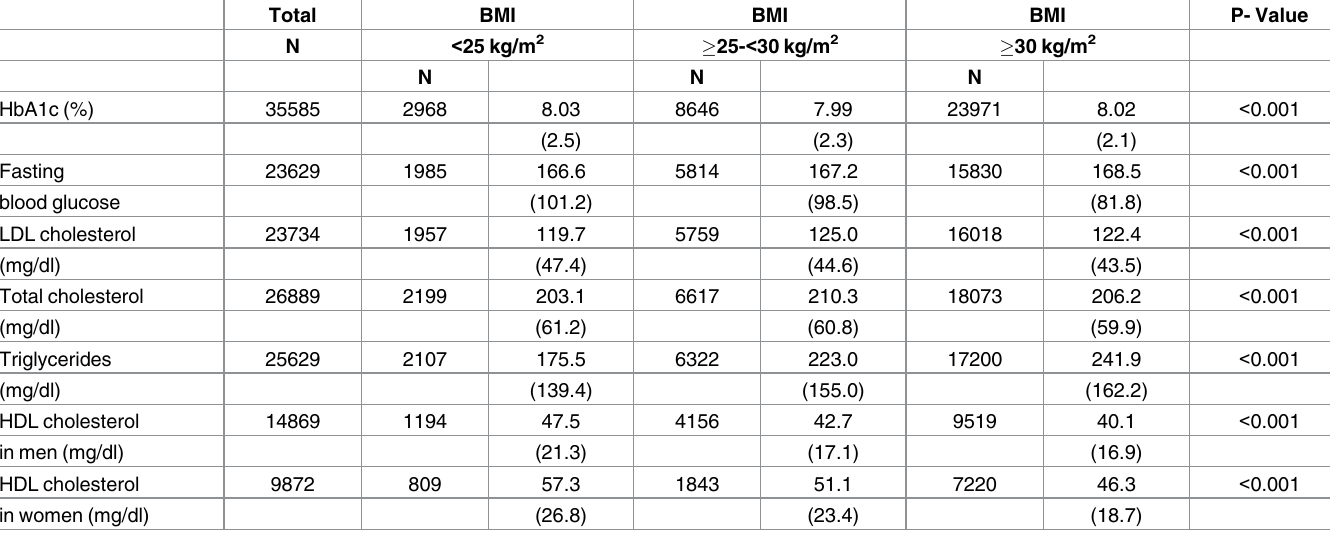
Table 2. Laboratory values (last recorded